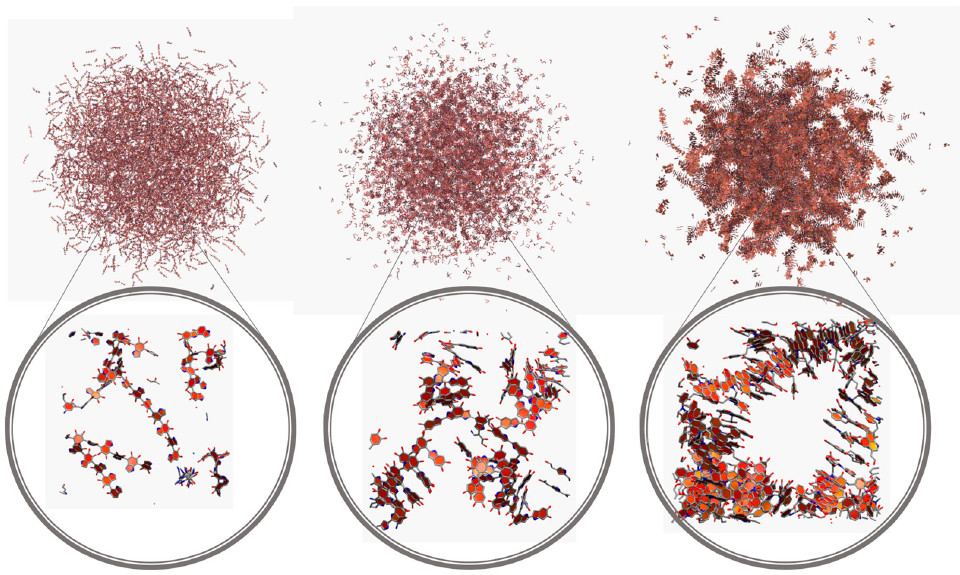
Figure 8. Representation of one configuration for the different PDA models (left to right: l DHI, TET-1, and PYR) in implicit solvent from the MD simulations. Table 2. Relative shape anisotropy ( κ 2 ) from the MD trajectories in implicit solvent for the large nanosphere models for the three candidates considered for